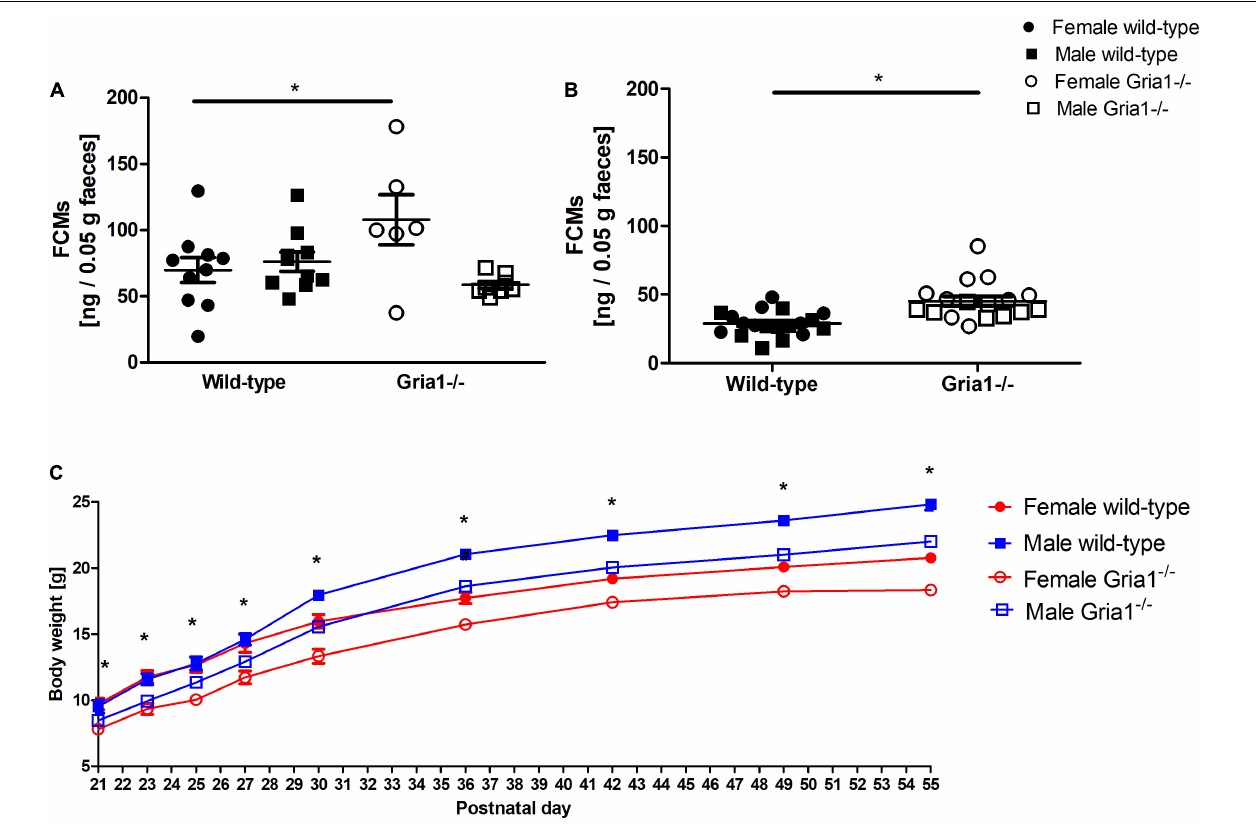
FIGURE 10 | Fecal corticosterone metabolites (FCMs) and development of body weight. In prepubescent mice, there was a significant effect of genotype and a relevant interaction with sex, indicating higher metabolite levels in the female Gria1 − / − group as compared to female wild-type littermates (A) . Gria1 − / − mice exhibited higher metabolite levels than wild-type littermates once sexually mature (B) . Monitoring of body weight (C) confirmed a significant effect of genotype on all days of weight assessment with Gria1 − / − mice reaching lower body weights than wild-type littermates. n = 6–10 per genotype per sex. ANOVA, followed by FDR correction or Bonferroni multiple comparison post hoc tests. * p < 0.05. Error bars indicate the standard error of the mean